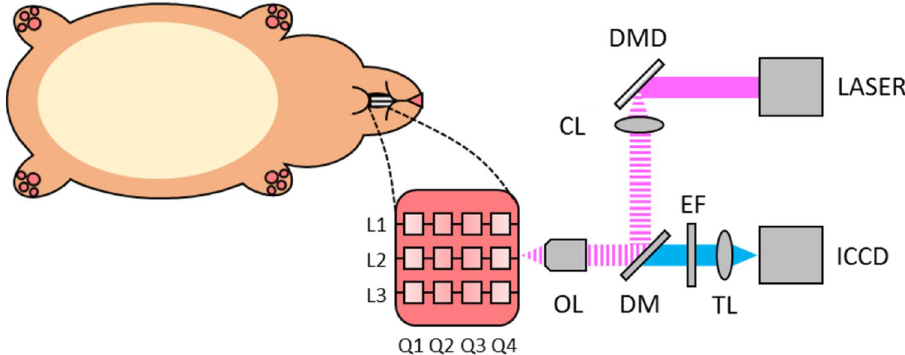
Figure 1. Diagram of experimental setup for imaging oral carcinoma development in hamster cheek pouch. A hamster is anesthetized and its cheek pouch is everted to give ~ 16 mm × 16 mm imaging area. Imaging was performed at twelve sites located in three lines (L1, L2, L3) divided into four quadrants (Q1, Q2, Q3, Q4). A conceptual drawing of the SI-FLIM devices is shown on the right. OL (objective lens), DM (dichroic mirror), EF (emission filter), TL (tube lens), ICCD (intensified CCD), CL (collimation lens), DMD (digital micromirror device), Laser (355 nm pulsed